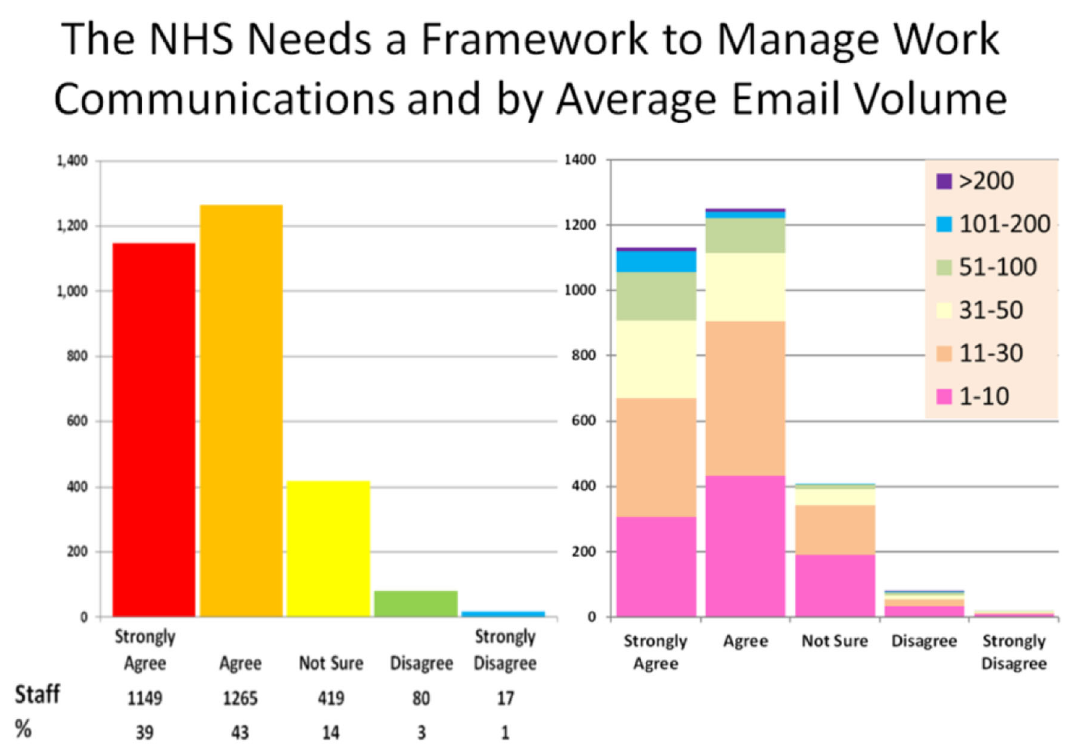
Fig. 4 Figure pertaining to data collected from survey Section 4, showing respondent views on need for a governance framework relating to digital communications, further analysed by reported average email